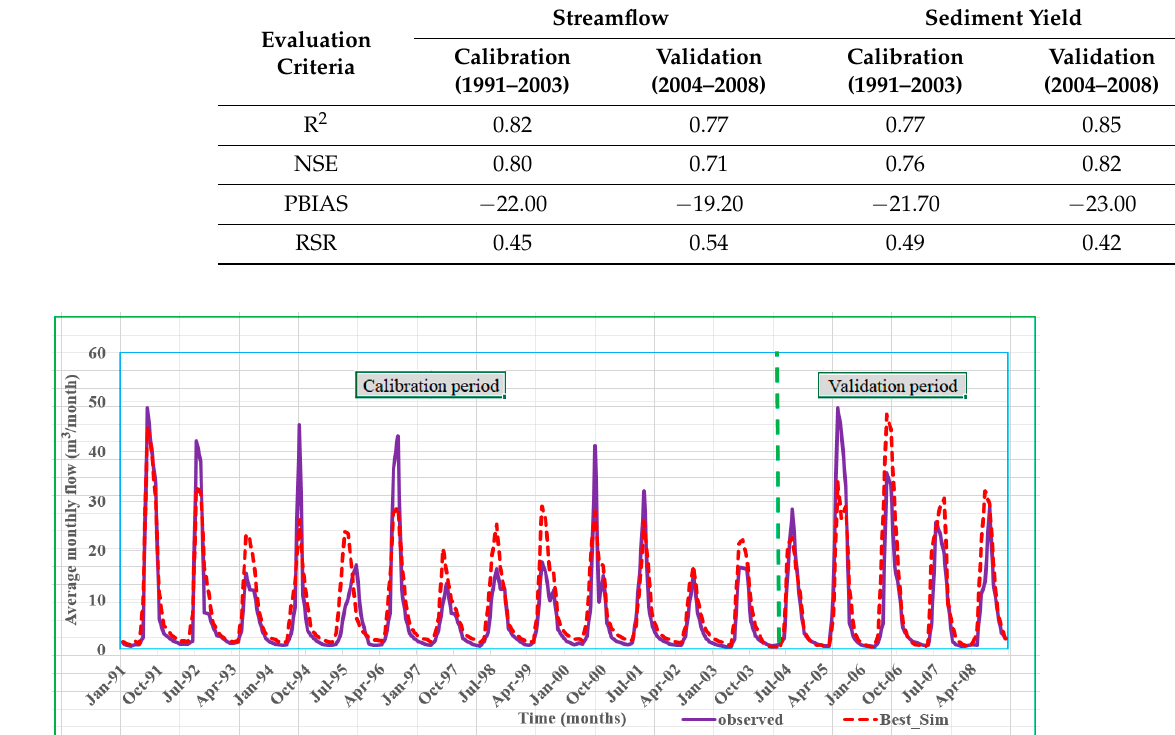
Figure 7. The hydrograph expressing the flow calibration and validation results at Merawi gaug- ing station.